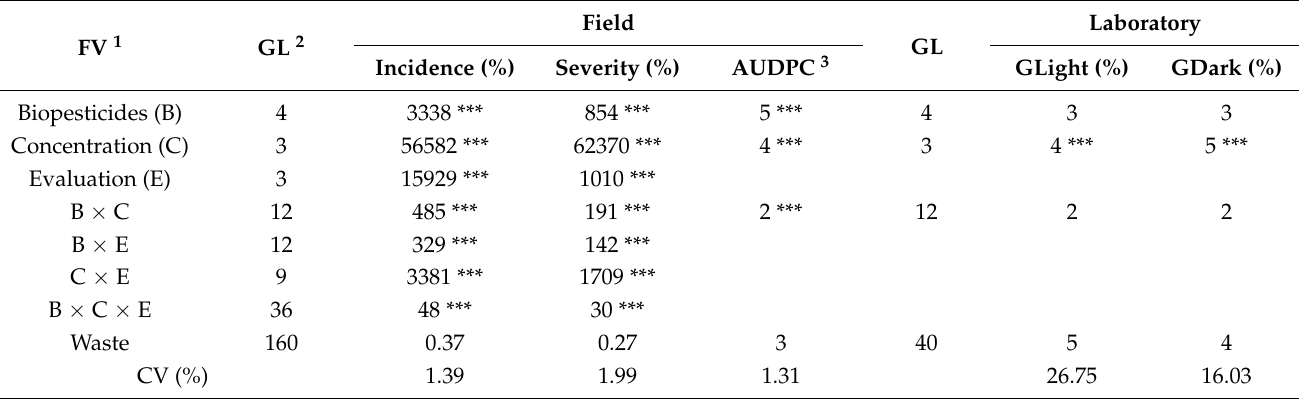
Table 1. ANOVA sum of squares results obtained when comparing five biopesticides, applied at four concentrations and evaluated on four different dates on coffee crop for rust